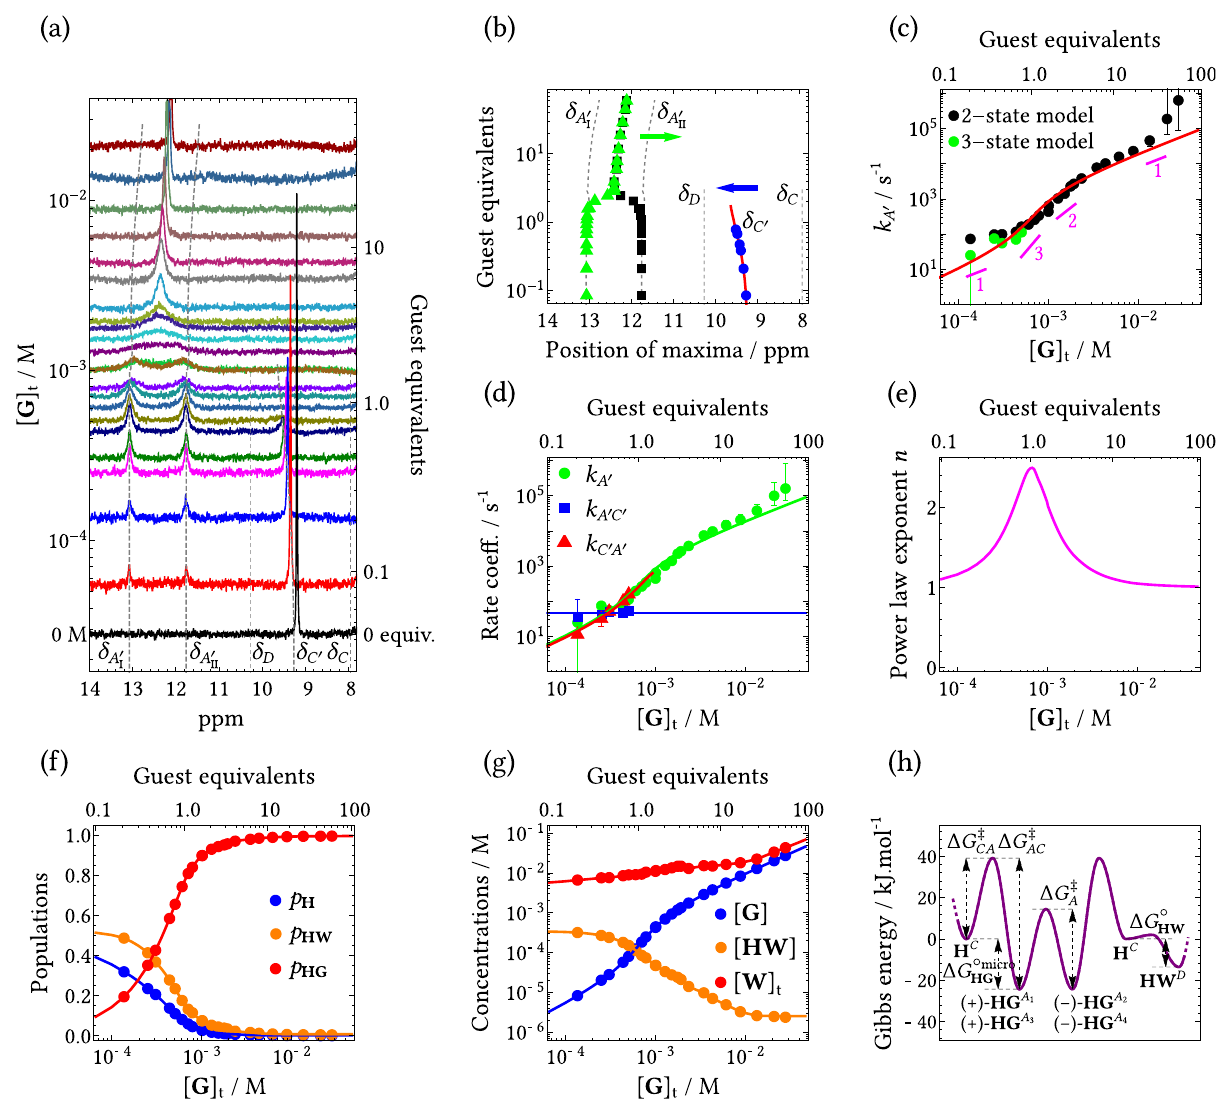
Figure 7. Experimental results for the host–guest system of di-bromobenzylated oxoporphyrinogen with 4 M , 10 ( R )-camphorsulfonic acid. ( a ) NH portion of 1 H NMR spectra of host H (initial concentration 6 − × CDCl 3 ) during the titration with guest G ( y -scaling of spectra is adjusted for clarity). Concentration of guest G corresponds to the value where the spectrum meets the y -axis. ( b ) Apparent positions of peak maxima during the titration, green and blue arrows denote the shift of maxima due to solvent polarity increase and fast exchange between states C (free H ) and D (host–water complex HW ), respectively. Red line is fit of the p C ω C p D ω D rescaled to ppm. ( c ) Concentration dependence of the transition rate coefficient frequency ω C ′ = + k A obtained using two-state lineshape fitting on states A ′ I and A ′ II (black circles) and using three-state lineshape ′ fitting on states A ′ I , A ′ II and C ′ (green circles). The red line is the best fit of the k A concentration dependence ′ within three-state model (two-state model is used above 1 equiv. due to the disappearance of the C state from NMR spectra) using Eqs. (26a) and (S45a,b). Magenta lines denote the slope of the red fitting curve. ( d ) Other transition rate coefficients describing the half-symmetric three-state exchange. The parameter k A was fitted ′ C ′ / p k A p C and k C was calculated ( k C A ′ I ). ( e ) Concentration dependence of the power law exponent. ( f ) ′ A ′ = ′ C ′ ′ ′ A ′ Concentration dependence of populations of host-related species. ( g ) Concentration dependence of free guest, host–water complex (both determined from the model in SI, Section S11.3) and total concentration of water (as determined from water peak integration, red solid line is interpolation). ( h ) Gibbs energy profile of all chemical 298 K and species as calculated from the Eyring equation, Eq. (23), from the reaction rate coefficients at T = 1 . Barriers (cid:31) G ‡ (cid:31) G ‡ setting the transition probability η CD and DC were not determined, since the corresponding = exchange process was too fast. The Larmor frequencies of states A ′ I and A ′ II are not unequivocally assigned with respect to the structures in Fig. 6c. Error bars in ( c ) and ( d ) denote maximum errors, see discussion in Section S12 in